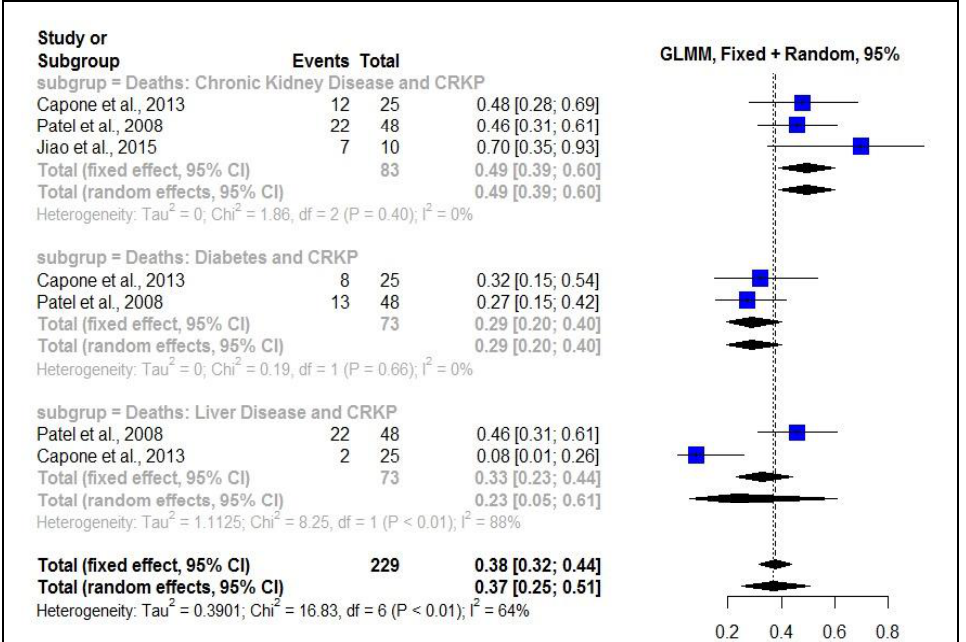
Figure 2. Test for proportion determination with a mixed generalized linear model (GLMM):Pro- portion of mortality of patients with comorbidities associated with CRKP.